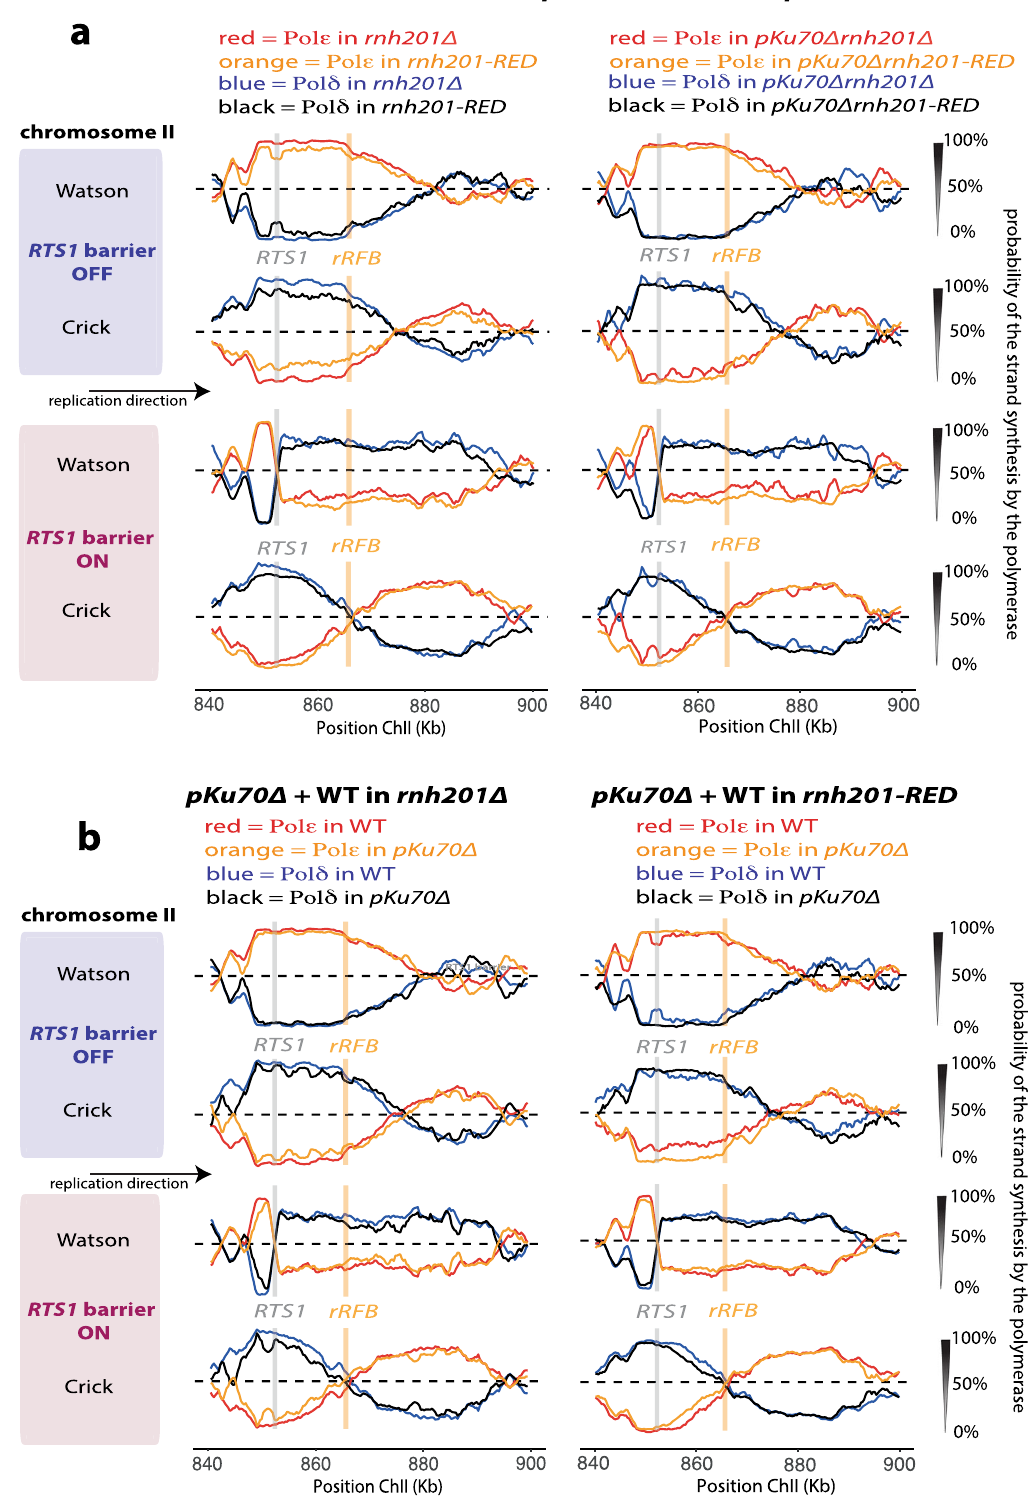
Fig. 4 Loss of pku70 + results does not destabilise the leading stand primer. a Overlays of Pu-seq traces of the RTS1-rRFB locus either with or without arrest and in the presence and absence of pku70 + . Left: in the rnh201-d background. Right: in the rnh201-RED background. b For the purpose of comparison, overlays of the Pu-seq traces for rnh201-d and rnh201-RED backgrounds. Left: in pku70 + . Right: in pku70-d